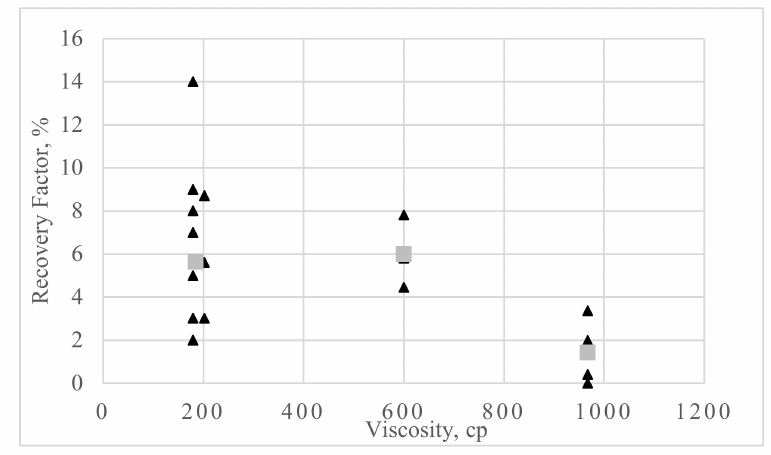
Figure 7. Incremental recovery factor and viscosity dependence for tertiary recovery.